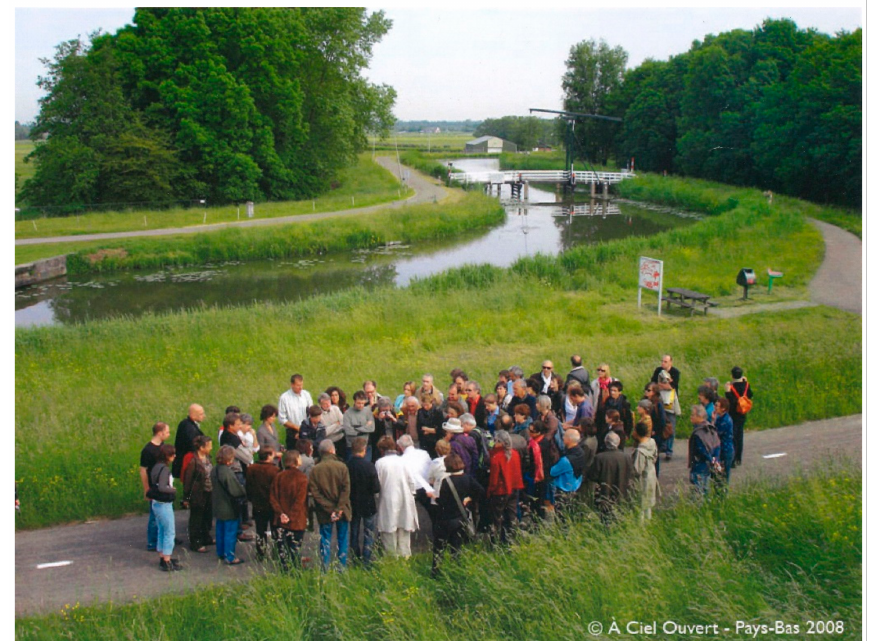
Figure 8. Students and staff from the É cole Nationale Sup é rieure de Paysage (ENSP) in Versailles on excursion to the Netherlands in 2008. Here a visit to the “Zuidplaspolder”, the deepest polder in the country; almost 7 m below sea level. The photograph is taken from the